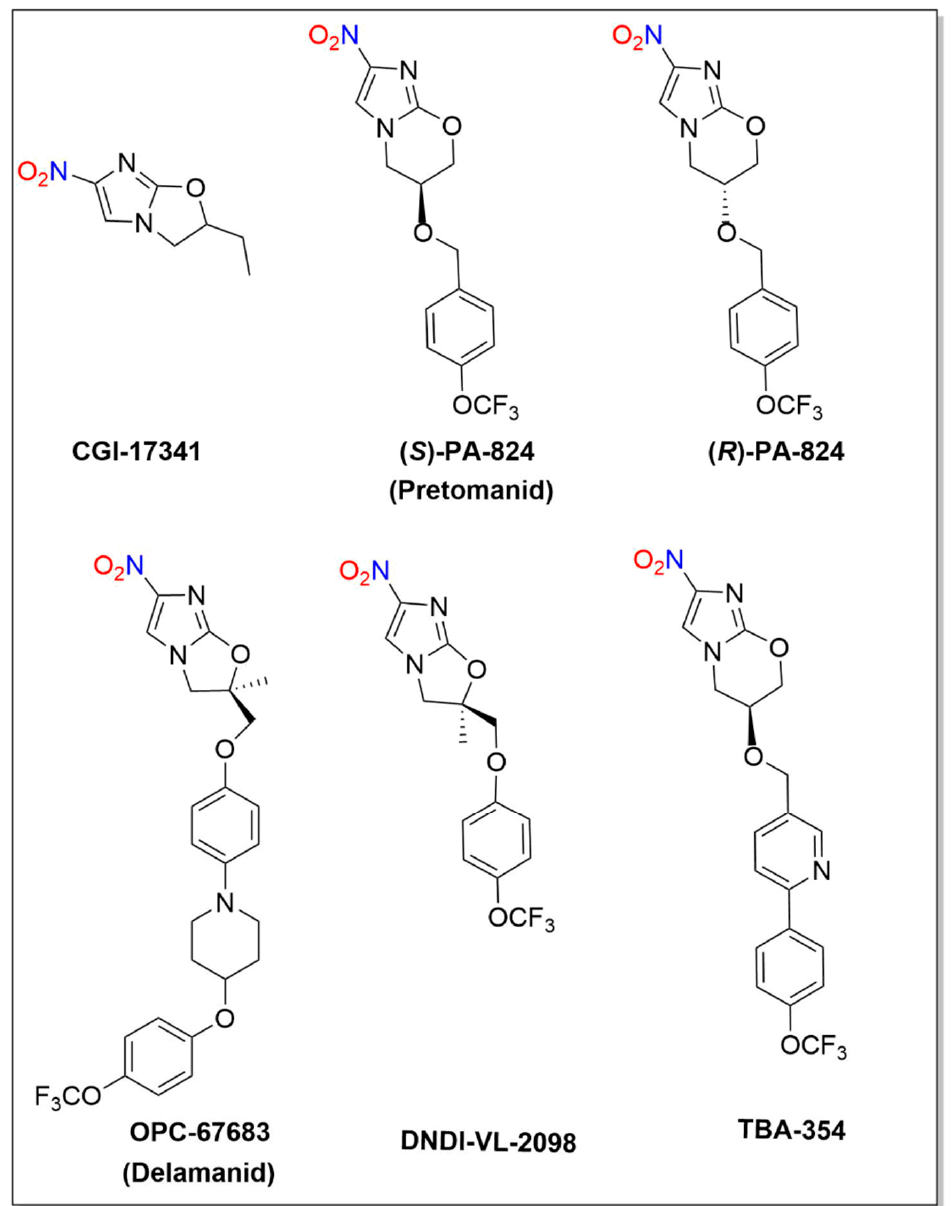
Figure 6. Structures of CG-17341, PA-824, OPC-67683, DNDI-VL-2098 and TBA-354.